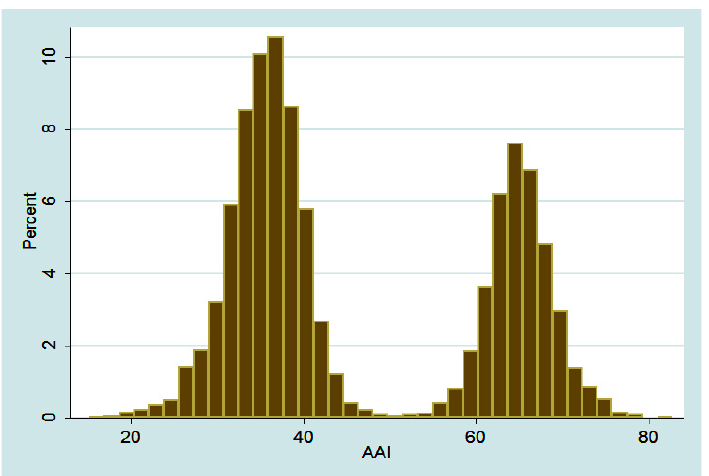
Figure 1. Distribution of the Values of the Healthy and Active Ageing Index.